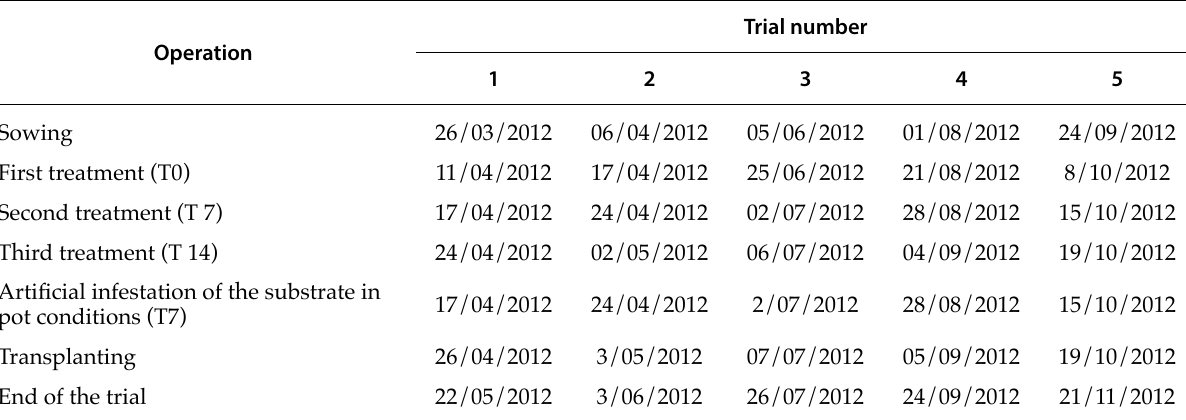
Table 1. Calendar of the main operations carried out in five